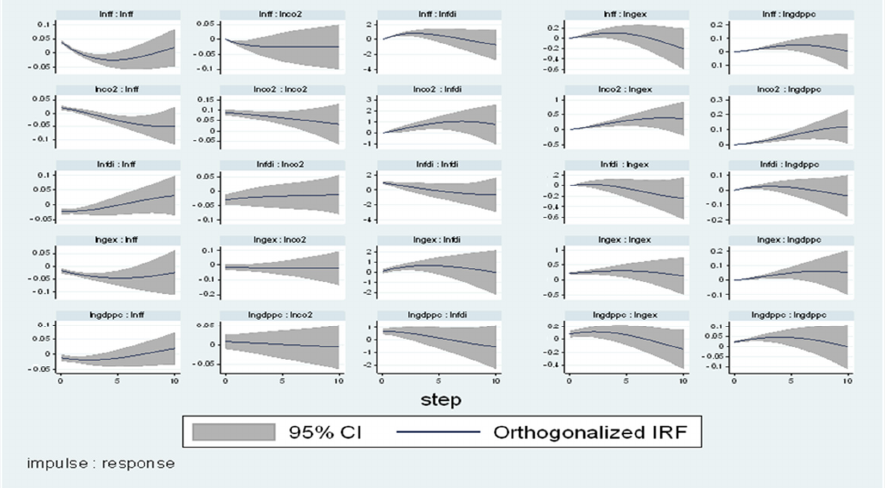
Figure 5. IRF-North.